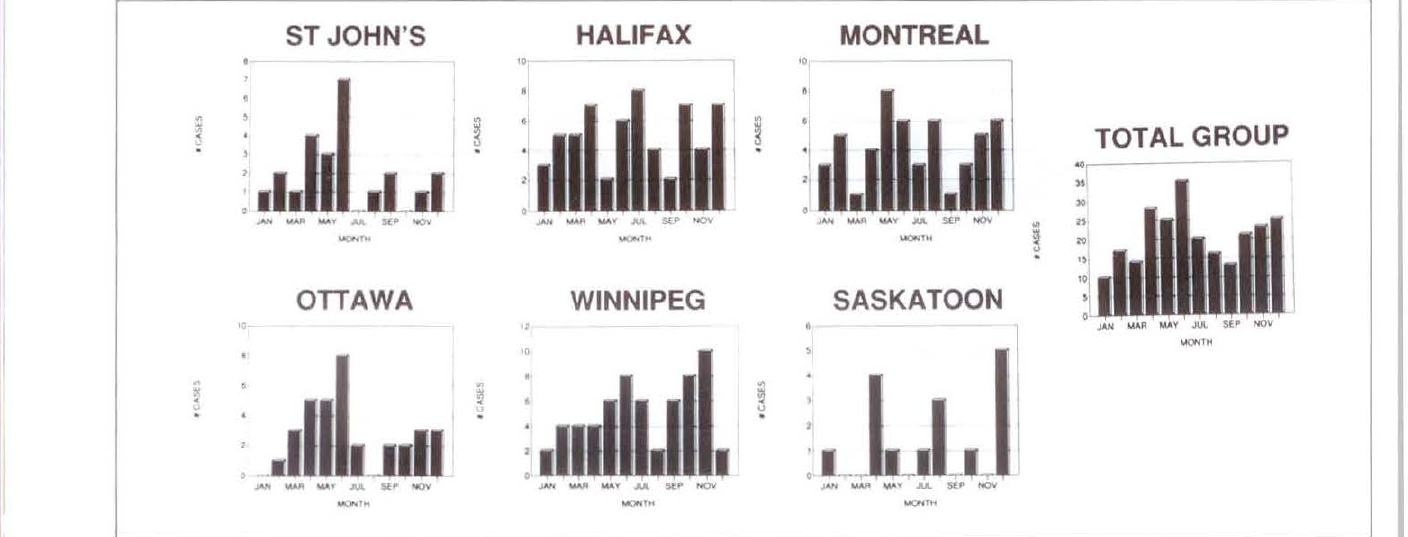
Figure 1) Centre specific monthly distribution q{cases determined using years for which the entire calendar year was available: StJohn's 1984·87: Halifax 1980 86: Montreal1982 85: Ottawa 1984·88: Winnipeg 1981 ·85: and